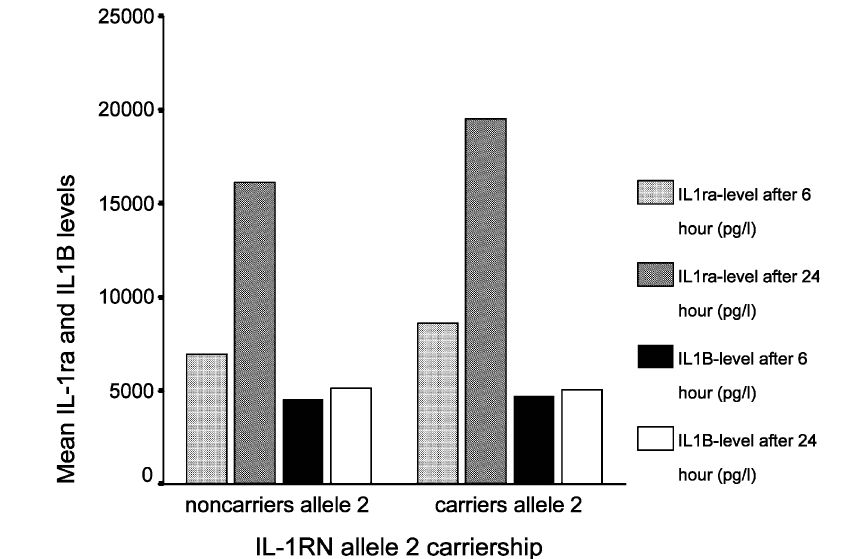
FIG. 1. IL-1ra and IL-1 b levels after 6 and 24 h in carriers(IL-1RNallele 2 (cid:2) / /IL-1B (cid:2) 3959 allele 2 (cid:3) / ) and non-carriers (IL-1RNallele 2 (cid:3) / /IL-1B (cid:2) 3959 allele 2 (cid:3) / ) of IL-1RN allele 2.